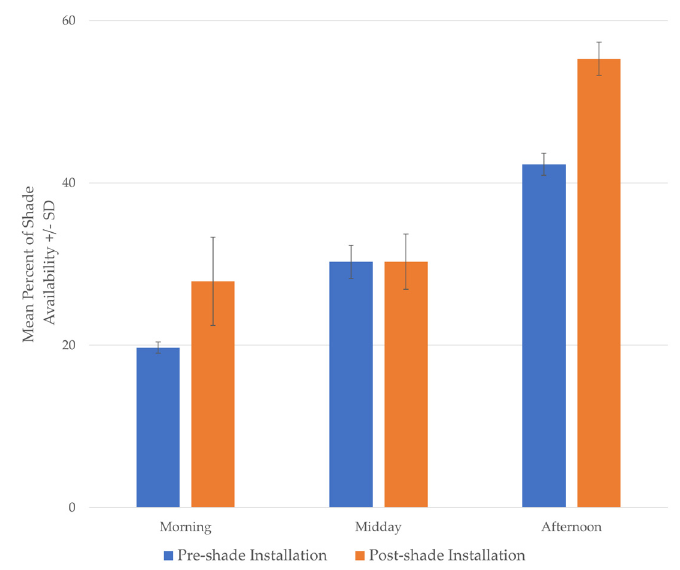
Figure 4. The mean percent of shade availability in the Sichuan takin enclosure at Lincoln Park Zoo before and after installation of a shade sail over a portion of the enclosure. To allow for comparisons across years, shade availability data is restricted for the months of June and July. Error bars represent the standard deviation above and below the mean.